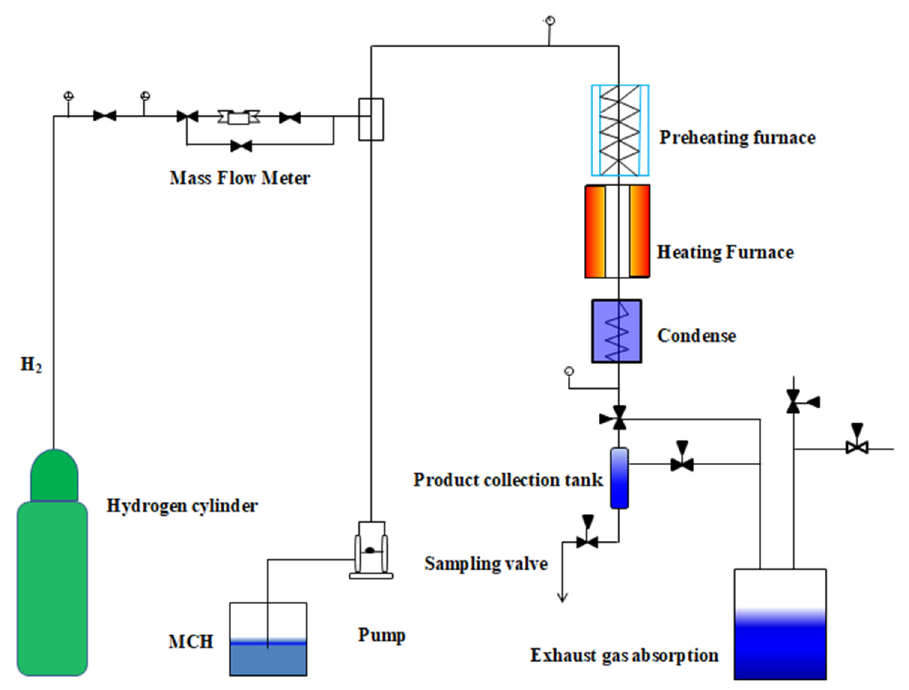
Figure 9. Process diagram of catalyst activity evaluation device.